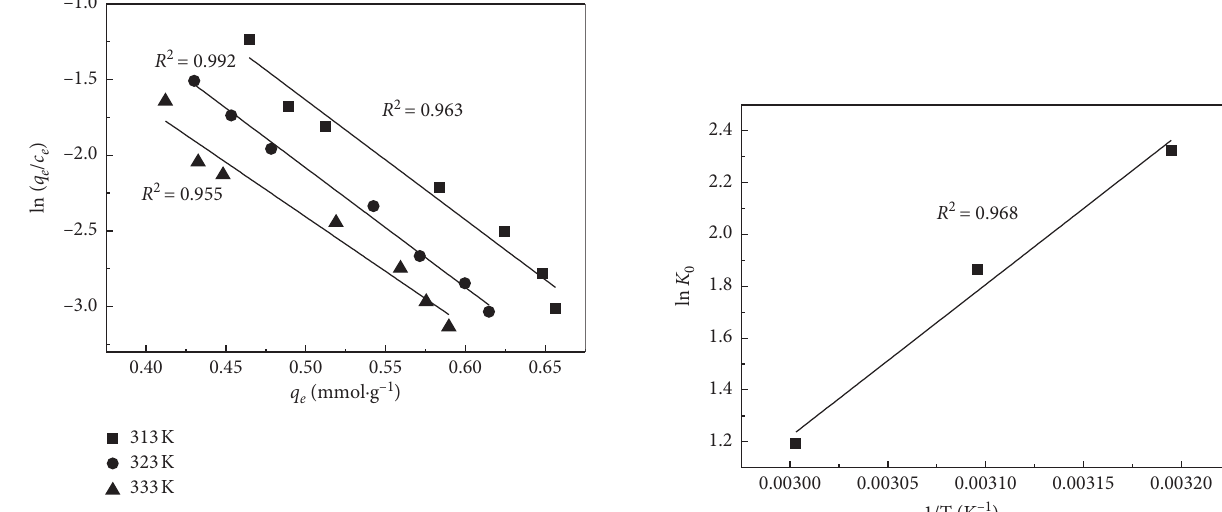
Figure 18: Plots of ln ( q e / c e ) versus q e for removal of DBT on Mn/AC. Figure 19: Plot of ln K 0 versus